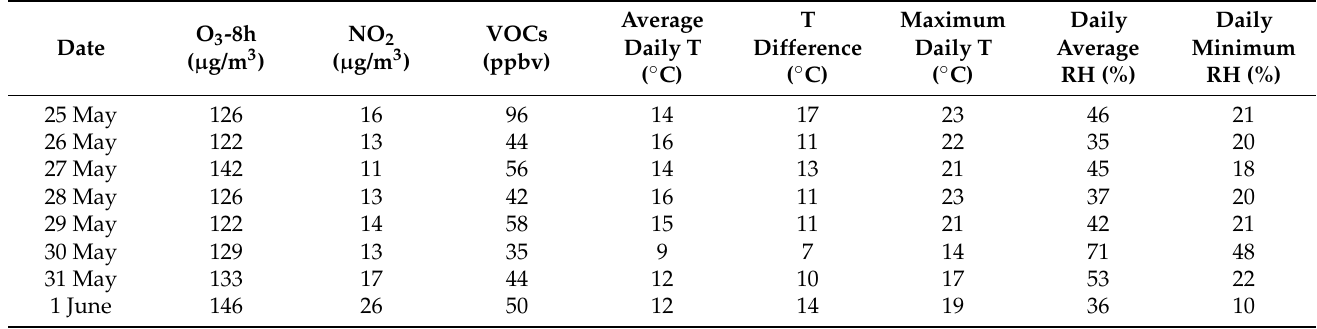
Table 1. Summary of meteorological factors, O 3 , NO 2 , and VOCs in the observation